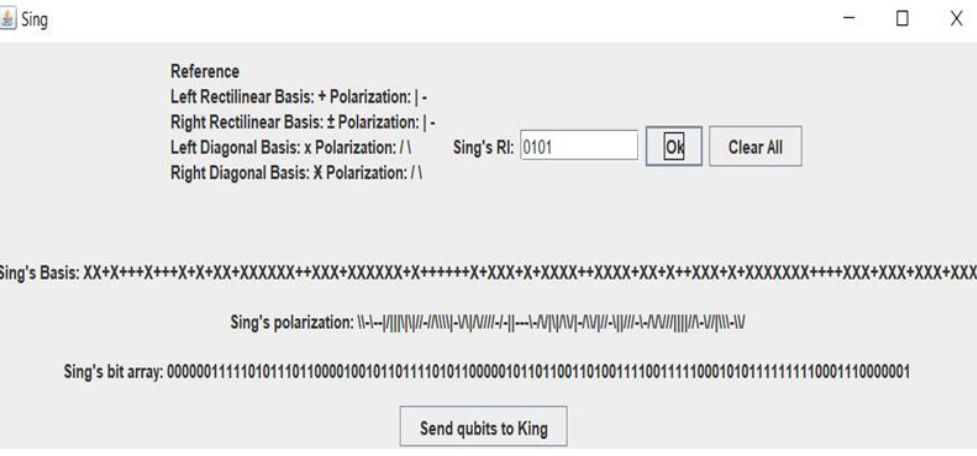
Figure 4. King calculated the multi-qubit list of Singh with his chaotic base list.